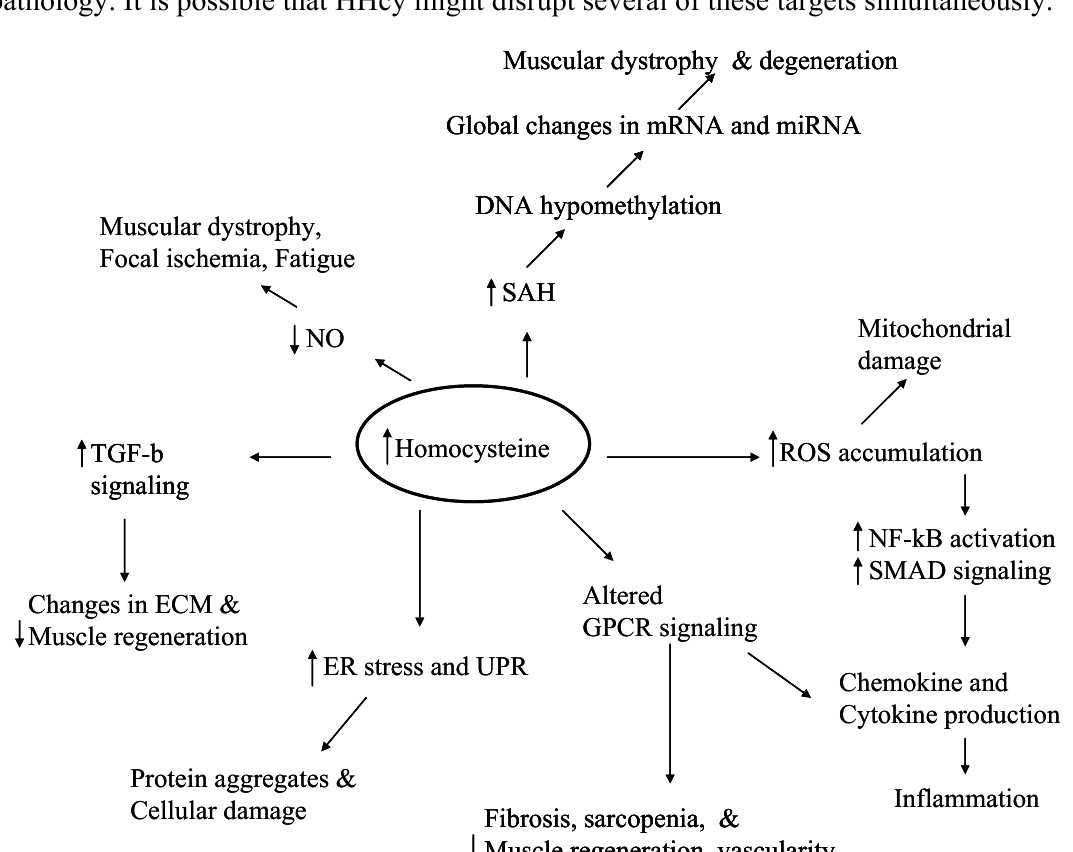
Figure 3. Schematic diagram showing the putative HHcy mechanisms in